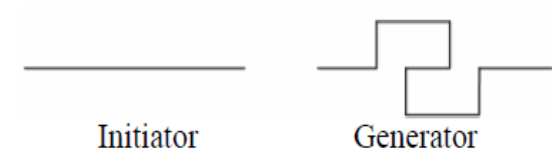
Figure 3: Giusepe Peano initiator and generator